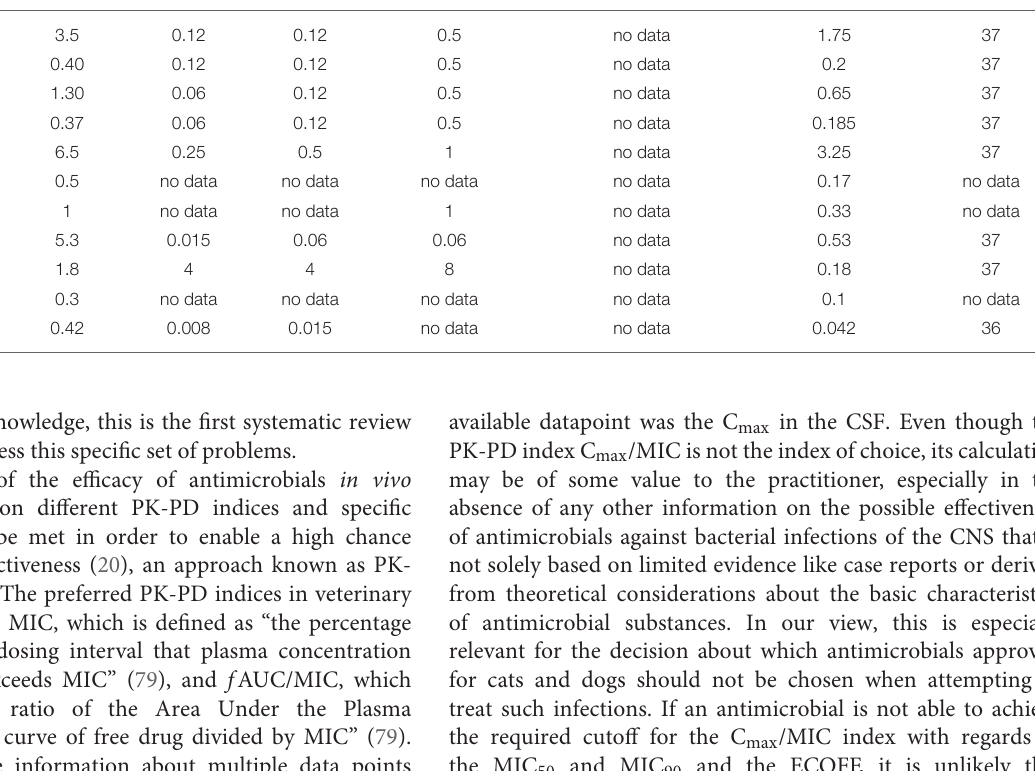
TABLE 11 | C max in CSF in dogs after the administration of various antibiotics in healthy dogs or during meningitis (ampicillin, benzylpenicillin) and selected PK-PD cutoffs of Pasteurella multocida . Active